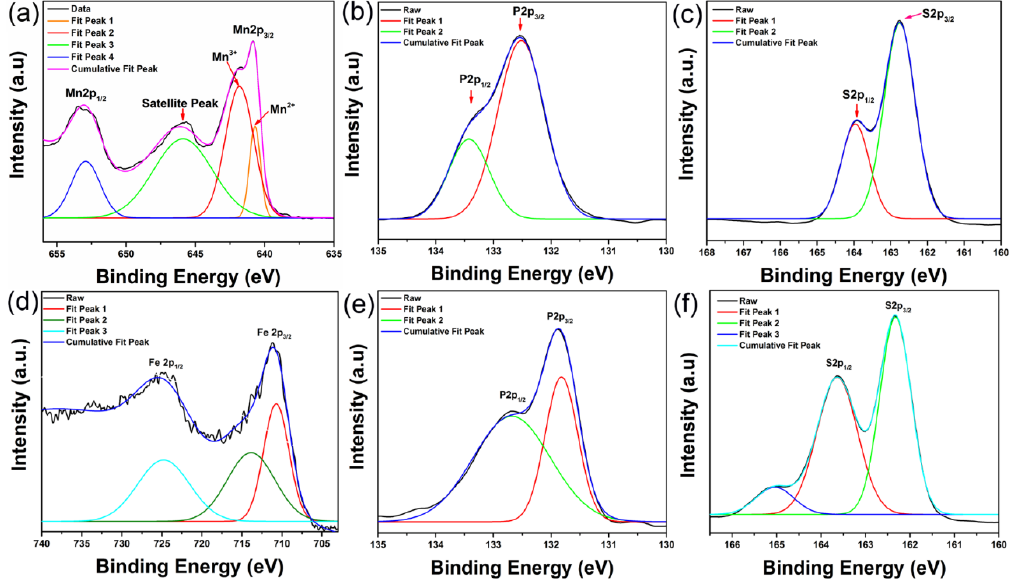
Figure 3. X-ray photoelectron microscopy of ( a – c ) MnPS 3 and ( d – f ) FePS 3 single crystals.